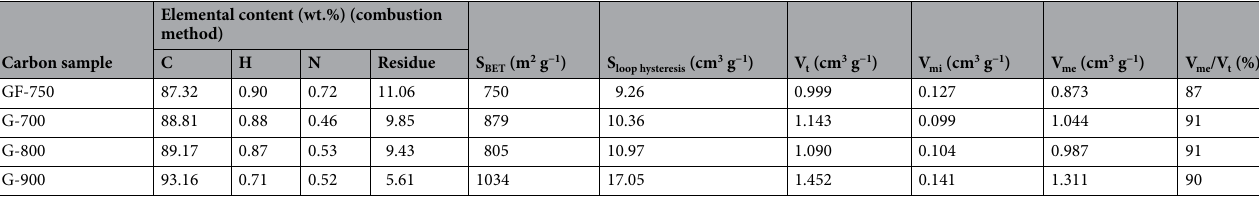
Table 1. Basic properties of graphene nanoplatelets and electrode materials derived therefrom.